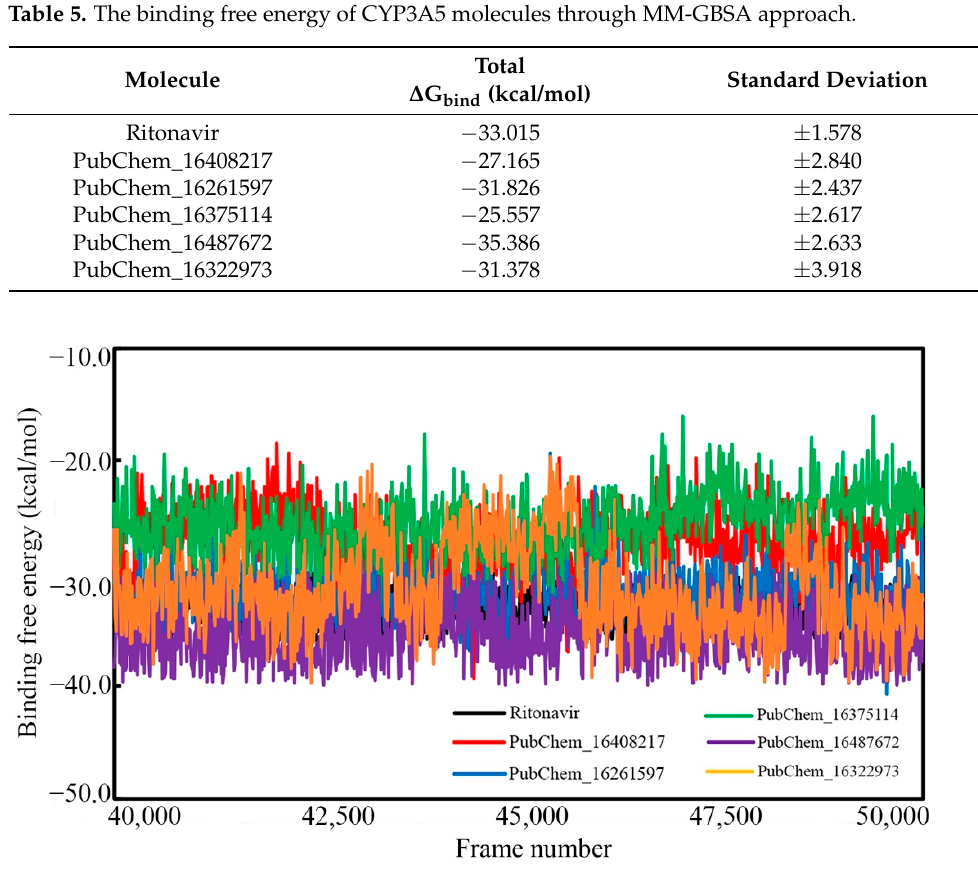
Figure 14. Binding free energy of CYP3A5 molecules vs. frame number.